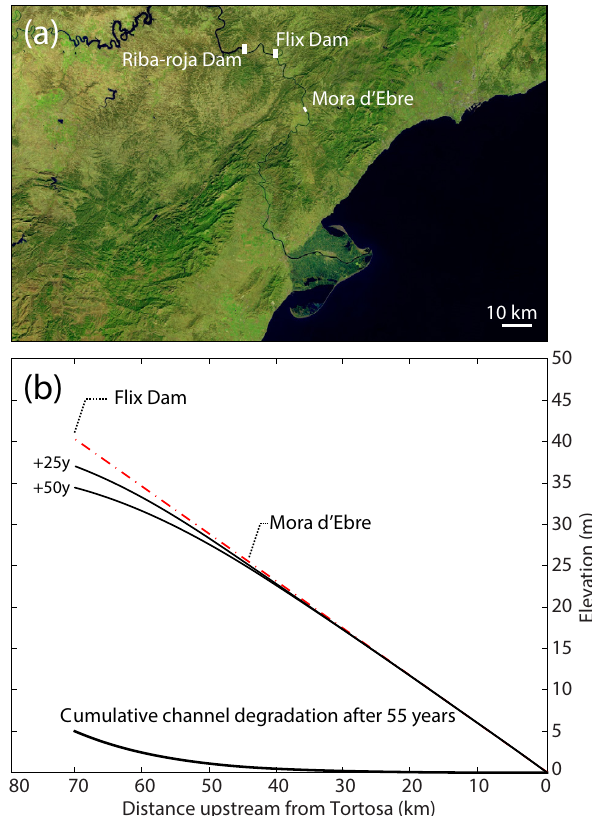
Figure 6. (a) A close-up of the Ebro drainage basin close to the delta (image from Landsat). (b) Modeled response of the Ebro River downstream of the lowermost modern dam, the Flix